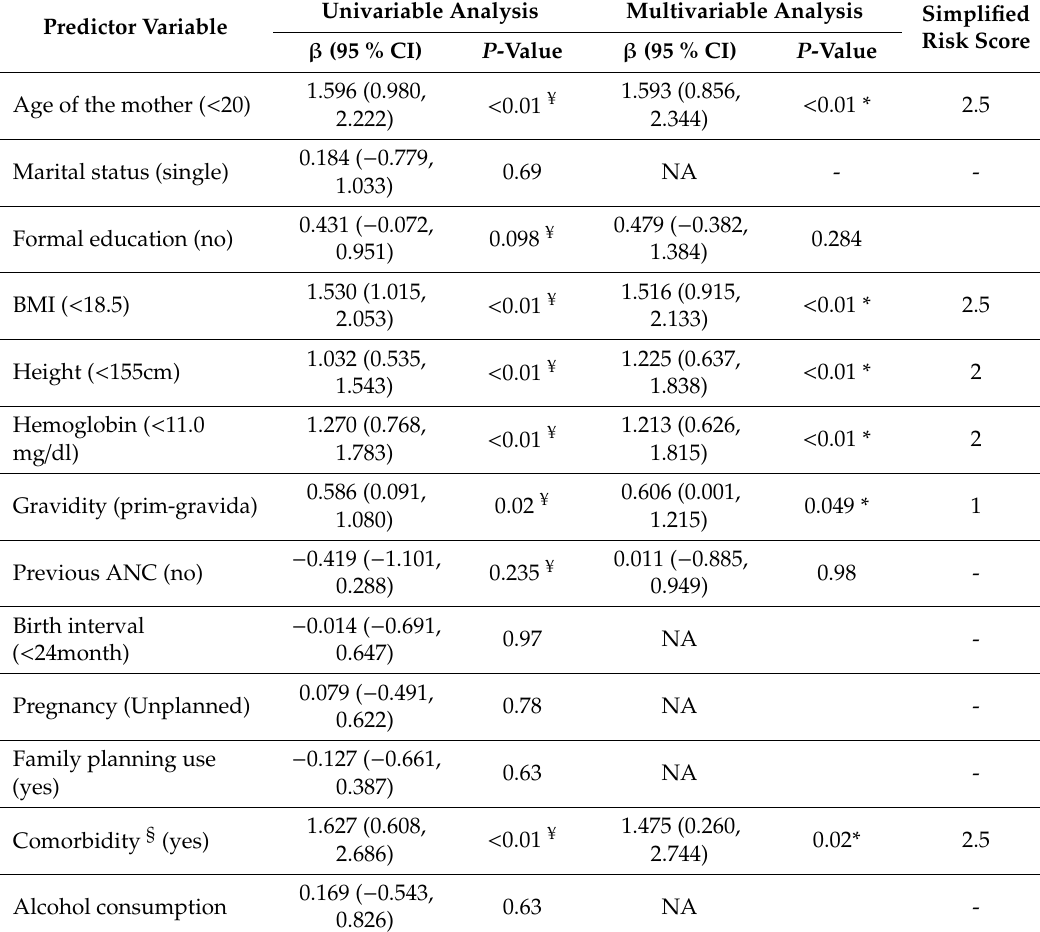
Table 2. Coe ffi cients and risk-scores of each predictor included in the model to predict low birthweight ( n = 379). Figures are numbers (percentages) unless mentioned